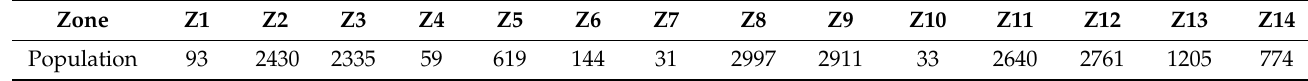
Table 1. Population of the 14 ESPOL zones in 2019 [53].